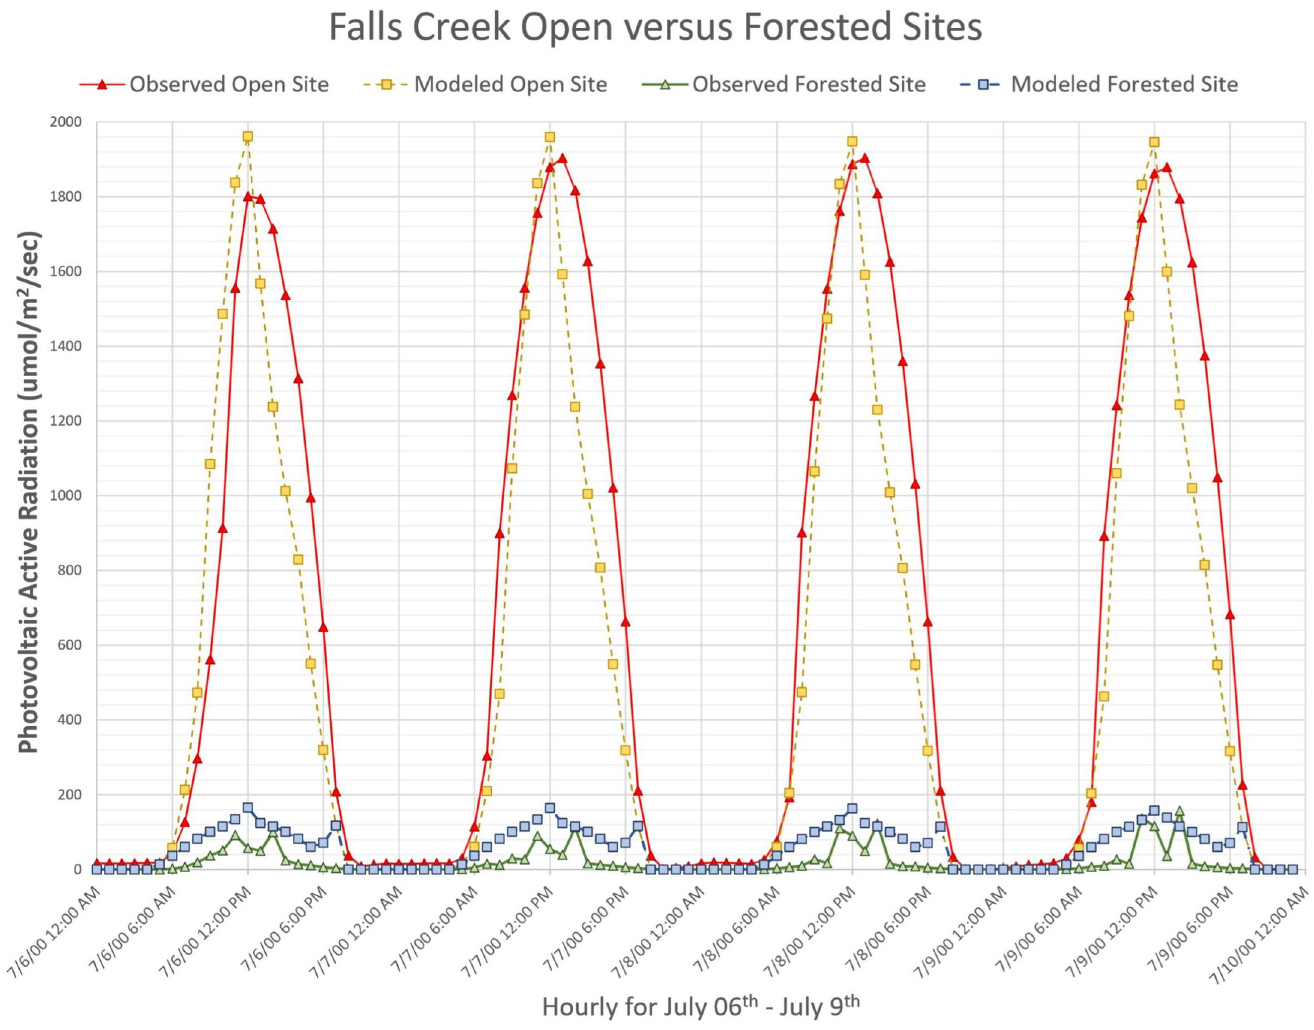
Fig 8. Falls Creek open-site versus forested-site. These plotted data represent simulated versus observed PAR ( μ moles/m 2 /s) for the O’CCMoN Falls Creek open- site and Forested-site. Note the magnitude of solar energy difference between the open versus forested